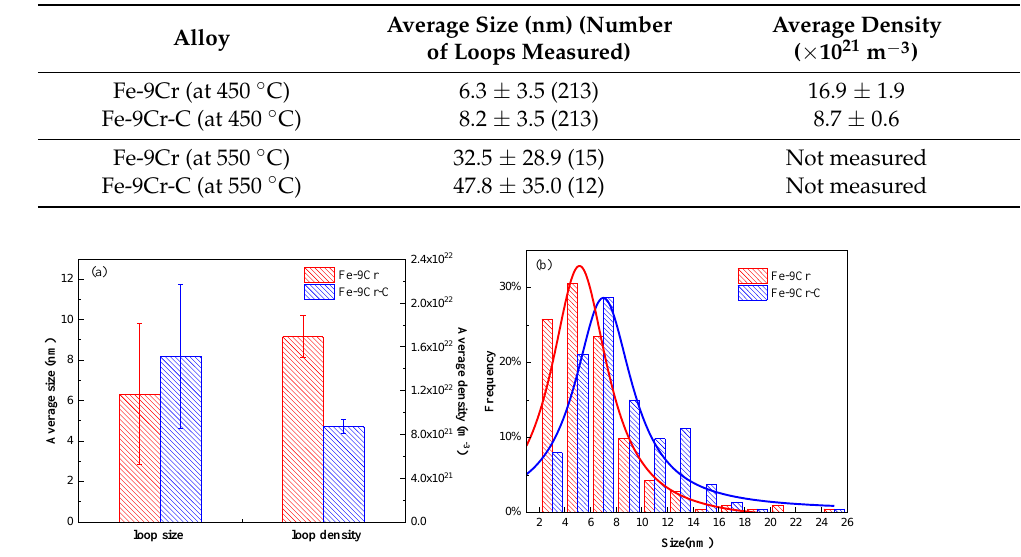
Figure 4. ( a ) Average size and density of the dislocation loops in the Fe-Cr alloys irradiated at 450 °C. ( b ) Size distribution of the dislocation loops in the Fe-Cr alloys irradiated at 450°C. In this experiment, the Fe-9Cr and Fe-9Cr-C alloys were irradiated in the same condi- tions, and the main difference between them was the different concentration of